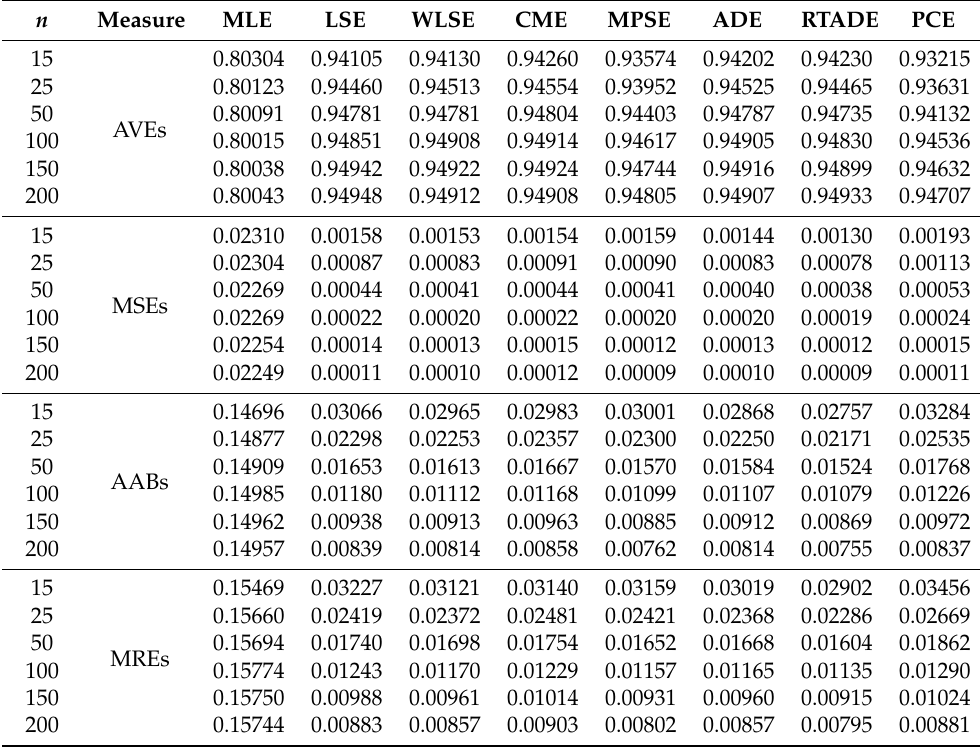
Table 6. Simulation results for the NDL distribution for θ =